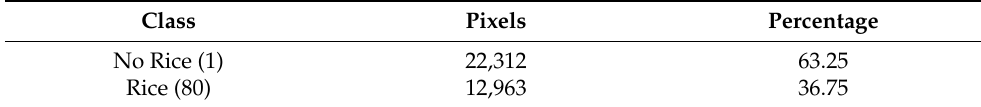
Table 3. Distribution between classes of the learning matrix.